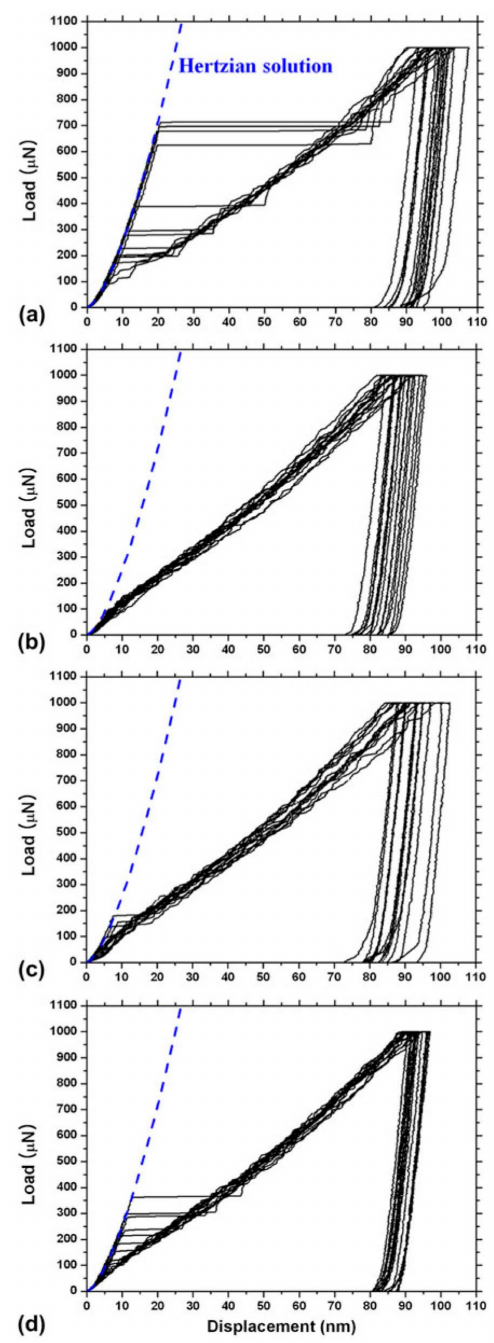
Figure 8. Load–displacement curves for a Fe–C alloy. ( a ) Fully annealed sample; ( b ) after a 6% uniaxial tensile prestrain; ( c ) 30 h after the prestrain; and ( d ) 3 weeks after the prestrain